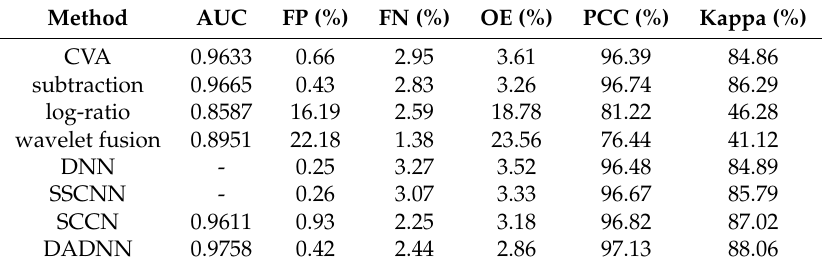
Figure A8. Change detection results obtained by different methods in the Guangzhou data set: ( a ) CVA, ( b ) subtraction, ( c ) log-ratio, ( d ) wavelet fusion, ( e ) DNN, ( f ) SSCNN, ( g ) SCCN, ( h ) DADNN, and ( i ) ground truth. Table A1. Value of evaluation criteria of the Guangzhou data